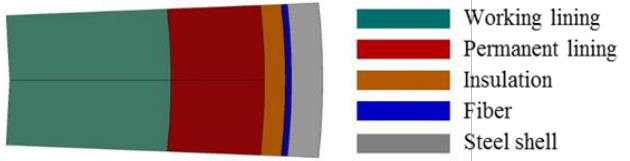
Figure 1. Two-dimensional model representing steel ladle slag zone linings [26].